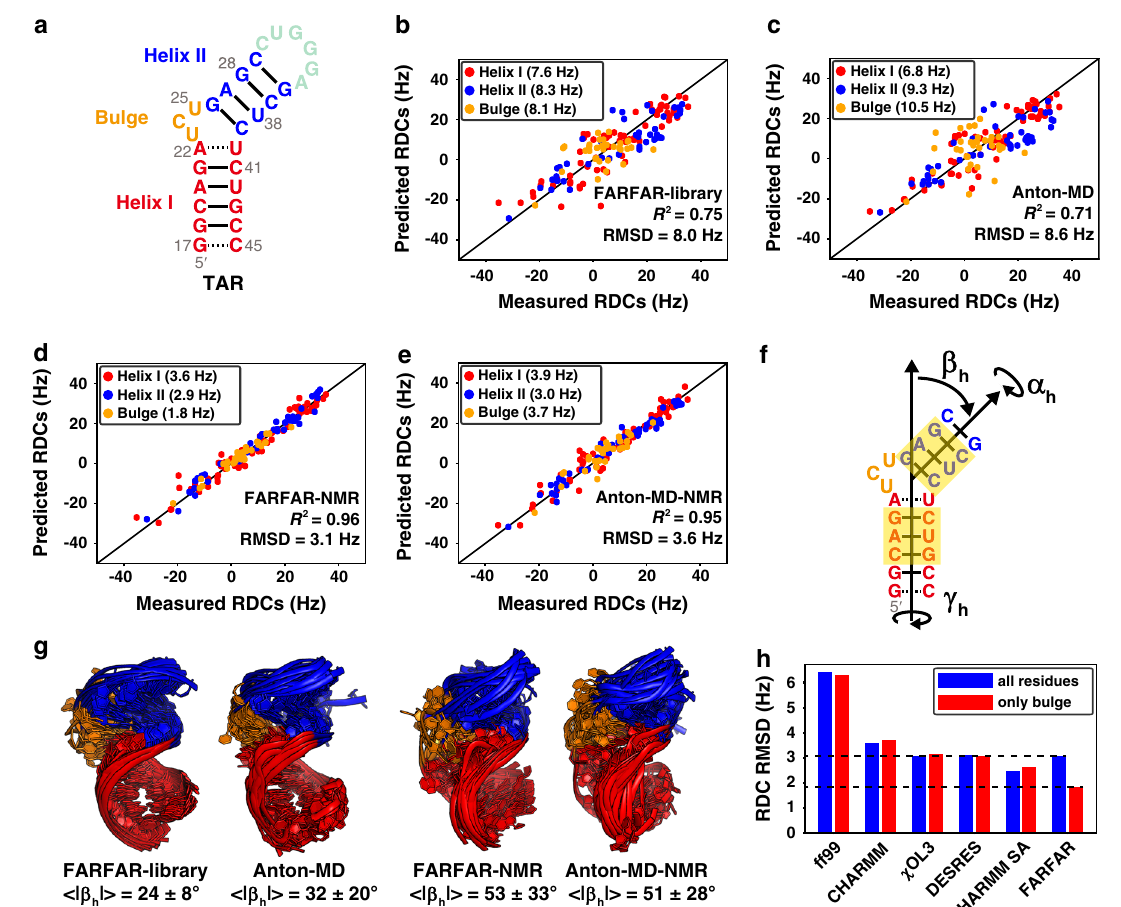
Fig. 2 Using FARFAR-NMR to determine a TAR ensemble. a Secondary structure of TAR. b – e Comparison between measured and predicted TAR RDCs for the b FARFAR-library ( N = 10,000), c Anton-MD library ( N = 10,000), d FARFAR-NMR ( N = 20), and e Anton-MD-NMR ( N = 20) ensembles. Values in parentheses denote the RDC RMSD. RDCs are color-coded according to the structural elements in a . f De fi nition of the three inter-helical Euler angles ( α h , β h , γ h ) describing the relative orientation of the two helices ( “ Methods ” ). The bps of the upper and lower helices used for de fi ning the Euler angles are highlighted in yellow. g Structural overlay of the TAR libraries and NMR re fi ned ensembles ( N = 20) ( “ Methods ” ). | β h | is the average absolute magnitude of the bend angle. h Comparison of RDC RMSD overall (blue) or bulge (red) residues for ensembles generated using different MD force fi elds (ff99 50 , CHARMM36 26 , ff99bsc0 χ OL3 51 , and modi fi ed ff14 DESRES 55 ), multiple simulations using a simulated annealing approach (CHARMM SA), and